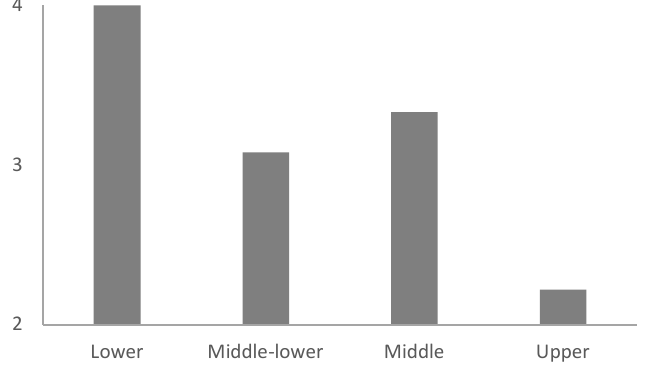
Figure 2. Average degree of teachers’ agreement with the statement "Socio-affective relationships among students have worsened", according to the socio-economic status of students.